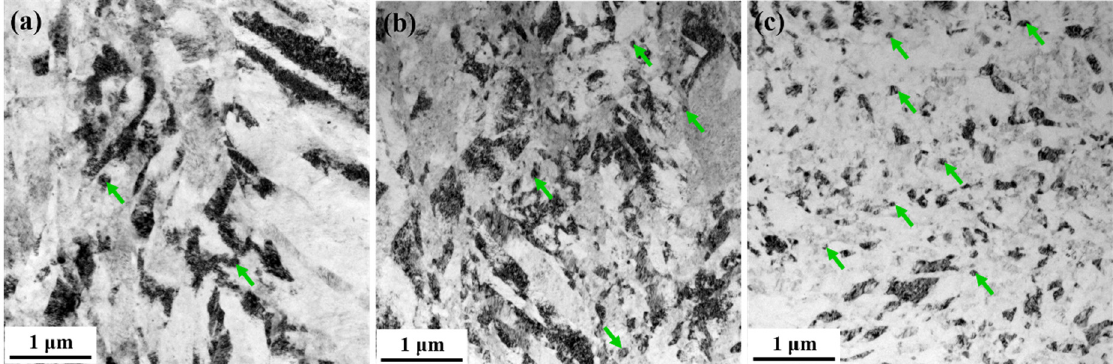
Figure 5. Microstructure in the central region of the alloy bars: ( a ) HS-3 sample; ( b ) E9S-3 sample; ( c ) E25S-3 sample. Nanoscale subgrains are indicated by the green arrows in the micrographs. Figure 6a,d show the NSGs (indicated as “NSG1” and “NSG2”, respectively) formed in HS-3 and E9S-1 samples, respectively. The grain sizes of NSG1 and NSG2 were ~80 nm. Both the boundary 1 (B 1 ) of NSG1 and the boundary 3 (B 3 ) of NSG2 had a misorientation of about 78°, which belongs to an abnormal {101 (cid:3364) 2} tension twin boundary [23,24]. The